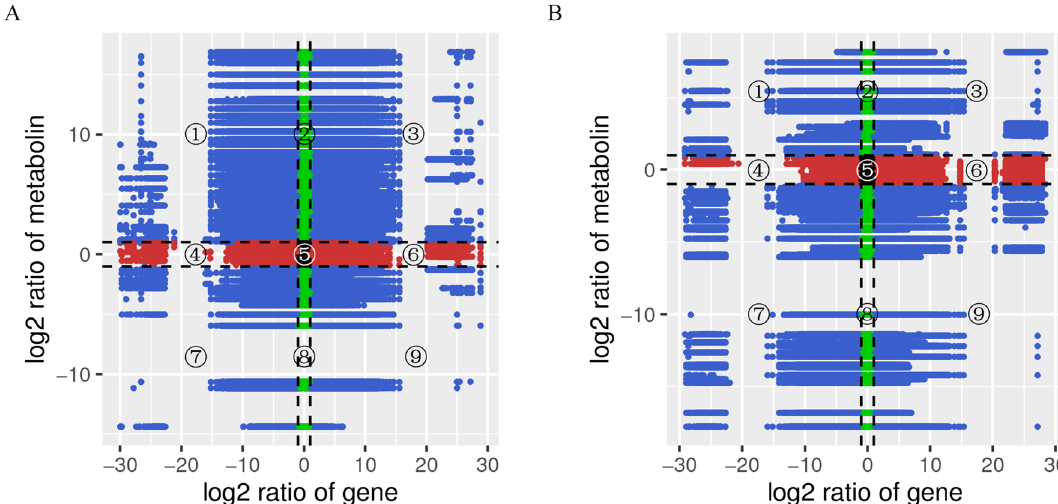
Figure 5. Quadrant diagrams representing the association of the DAMs and DEGs be-tween large flower taxa and small flower taxa in Herba Epimedii . The x-axis represents that the log2 ratio of gene and the y-axis represents the log2 ratio of metabolite; black dot-ted lines represent the different threshold; each point represents a gene or metabolite; black dots represent the unchanged genes or metabolites; green dots represent differentially ac-cumulated metabolites with unchanged genes; red dots represent differentially expressed genes with unchanged metabolites; blue dots represent both differentially expressed genes and differentially accumulated metabolites; it is divided into ① – ⑨ quadrants from left to right and from top to bottom with black dotted lines; the ① , ② and ④ quadrants indicate that the expression abundance of metabolites is higher than that of genes; the ③ and ⑦ quadrants indicate that the expression patterns of genes are consistent with the metabolites; the ⑤ quadrant indicates that the genes and metabolites are not differentially expressed; the ⑥ , ⑧ and ⑨ quadrants indicate that the expression abundance of metabolites is lower than that of genes. ( A) In flowers. ( B) In (Fig. 9). The metabolic pathways of two common flavonoids in Herba Epimedii are shown in Fig. 10. The results showed that the expression of CHS (Cluster-15486.53035) and ANR (Cluster-15486.44844) were significantly downregulated in leaves, whilst the expression of DFR (Cluster-15486.38067) was upregulated in small vs. large flower taxa. Moreover, genes (Cluster-15486.29698) encoding caffeoyl-CoA-O-methyltransferase (CCOAOMT) were strikingly upregulated in the leaves of small flower taxa, and two genes (Cluster-72560.171519, Clus- ter-72560.176015) encoding CCOAOMT were upregulated in the flowers of the small flower taxa. These data highlight the ability of the flower taxa to induce flavonoid synthesis related genes to varying degrees, particularly those regulating the expression of CCOAOMT.